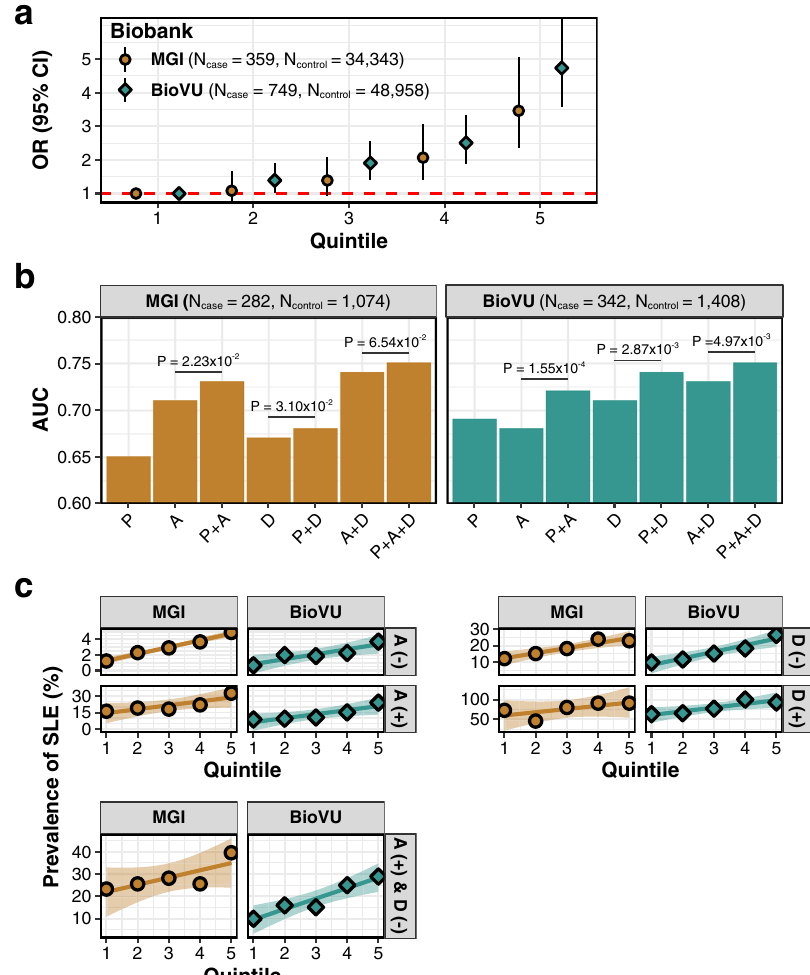
Fig. 5 | Applications of PRS model derived from LASSOSUM using multi- ancestry and multi-trait GWAS data. a The odd ratios (OR) and 95% con fi dence intervals(CIs;bars)ofeachPRSstratusagainstindividualsinthelowestquintile.We strati fi ed PRS into 5 groups with the bottom quintile used as the reference group. ThereddashedlineindicatesOR=1. b AUCofPRS(P),ANA(A),anti-dsDNA(D),and whenthesetestsareusedtogethertodiagnoseSLE.Pvaluesarecalculatedviaone- sided Delong ’ s test. It should be noted that this analysis is done in a subset of